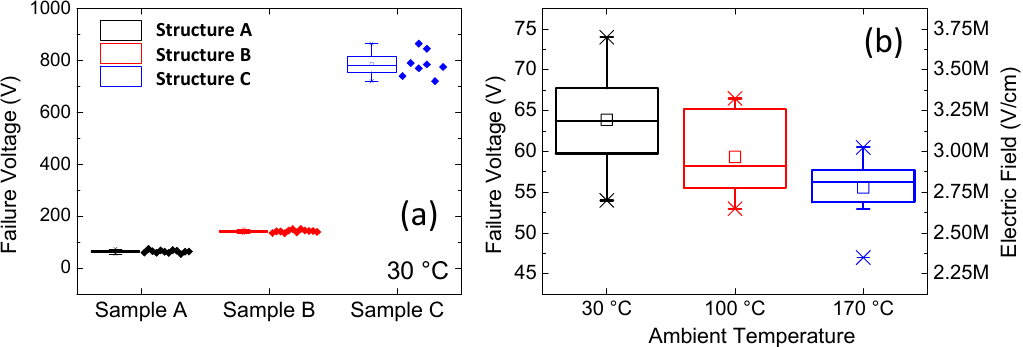
Figure 10. ( a ) Breakdown voltage evaluated on the three wafers under analysis; ( b ) dependence of the breakdown voltage of wafer A on temperature.